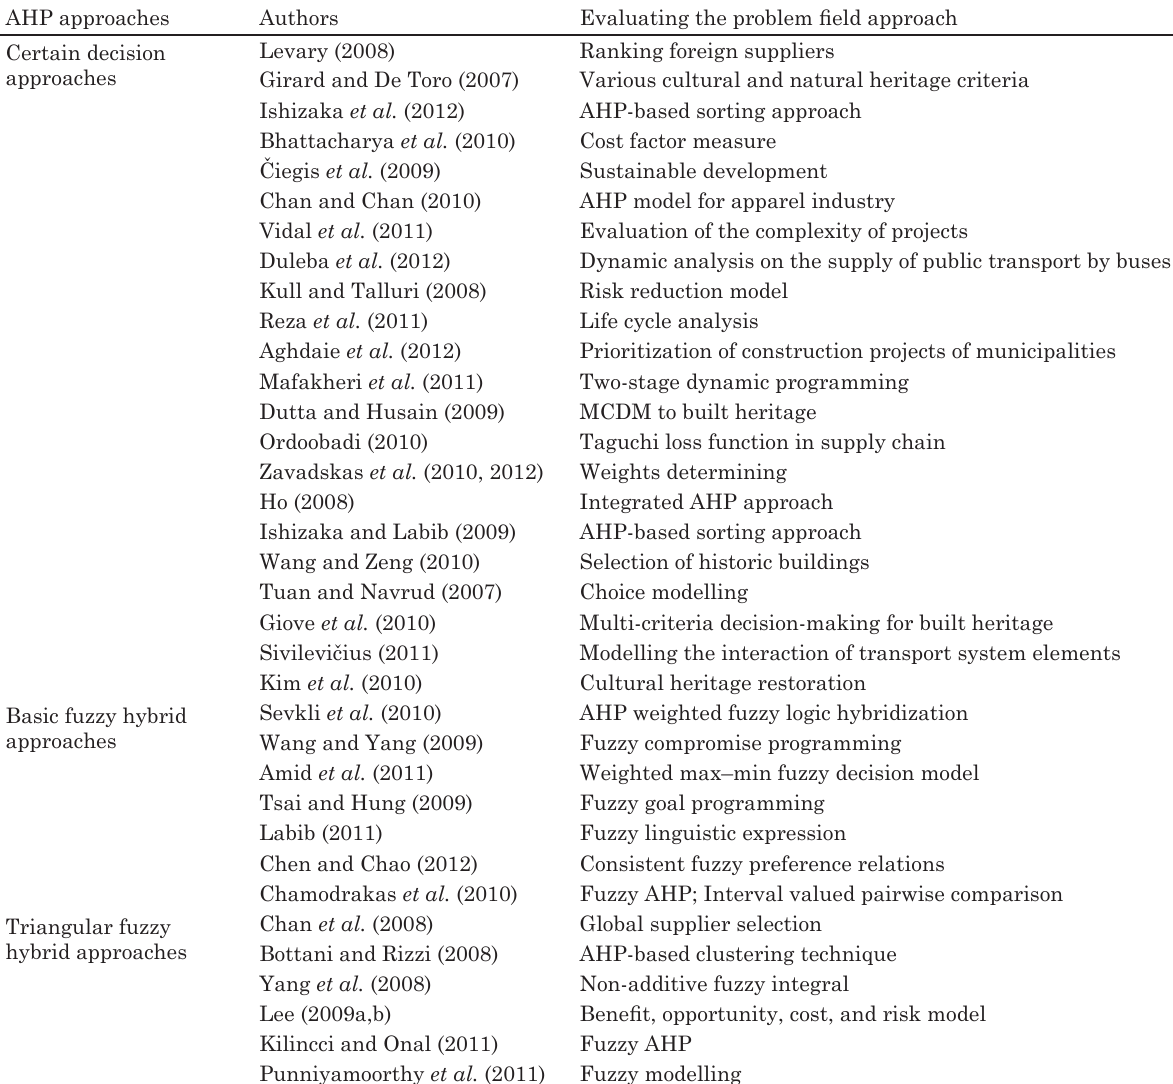
Table 1. The decision approaches using AHP decision method techniques AHP